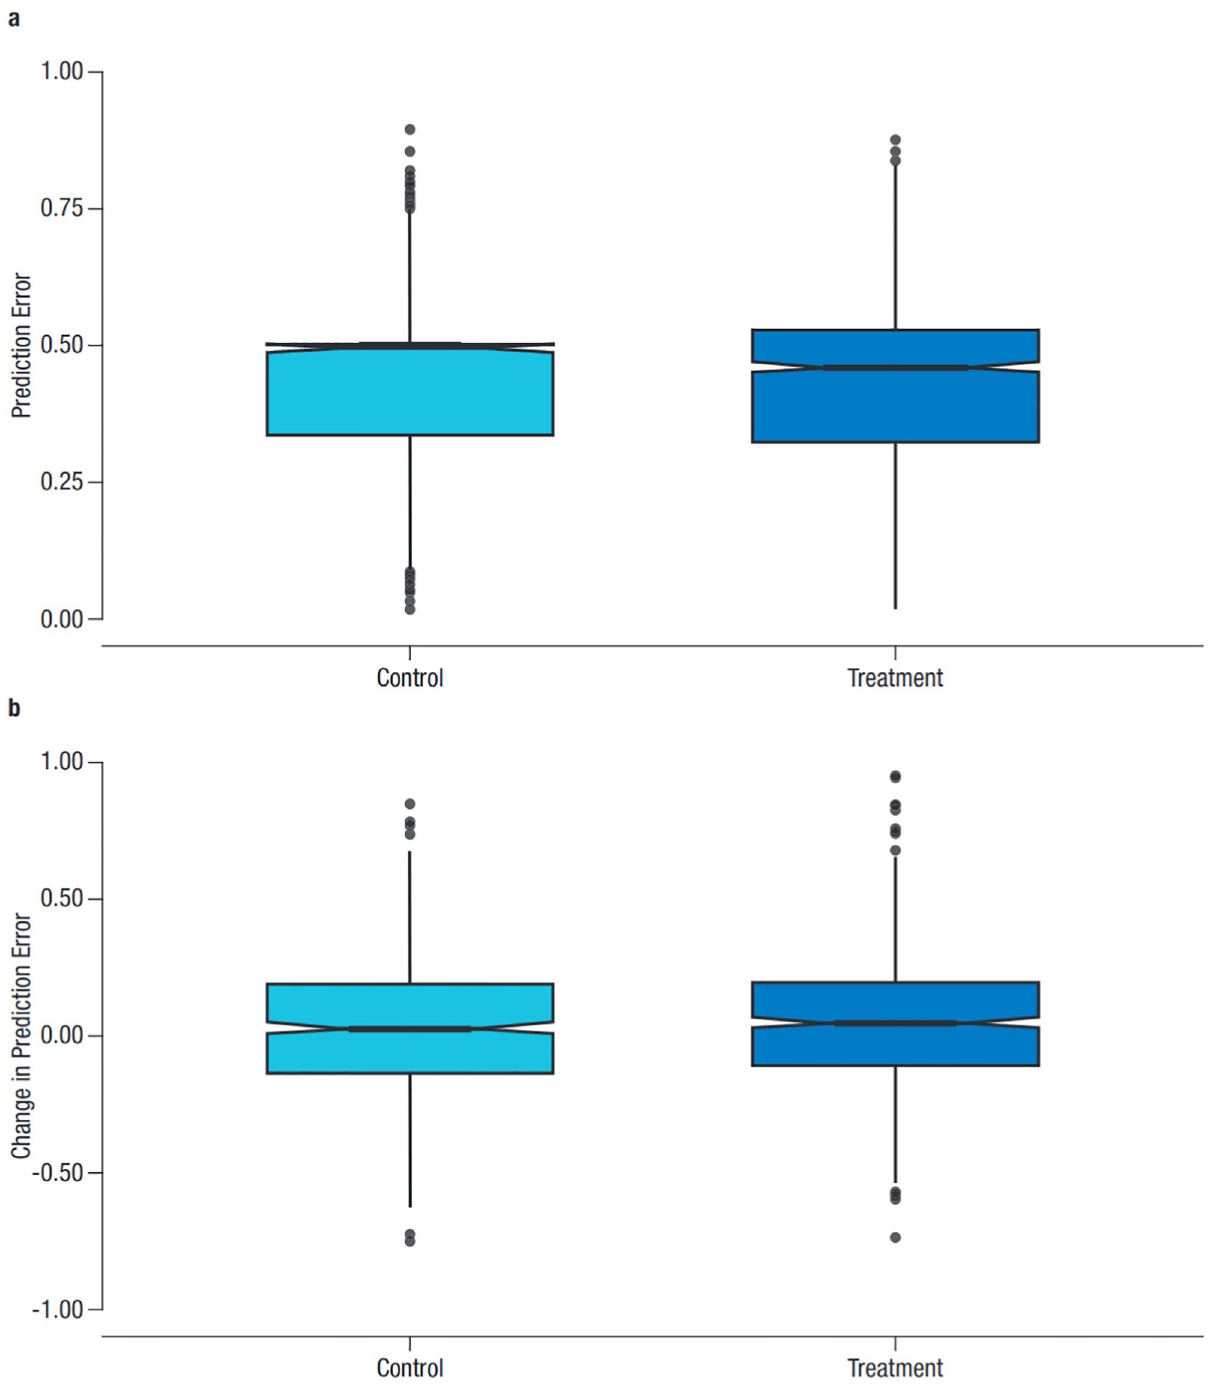
Fig 4. Boxplot of Team Median Prediction Errors (top panel) and the Difference between Initial and Final Median Prediction Error (bottom panel).